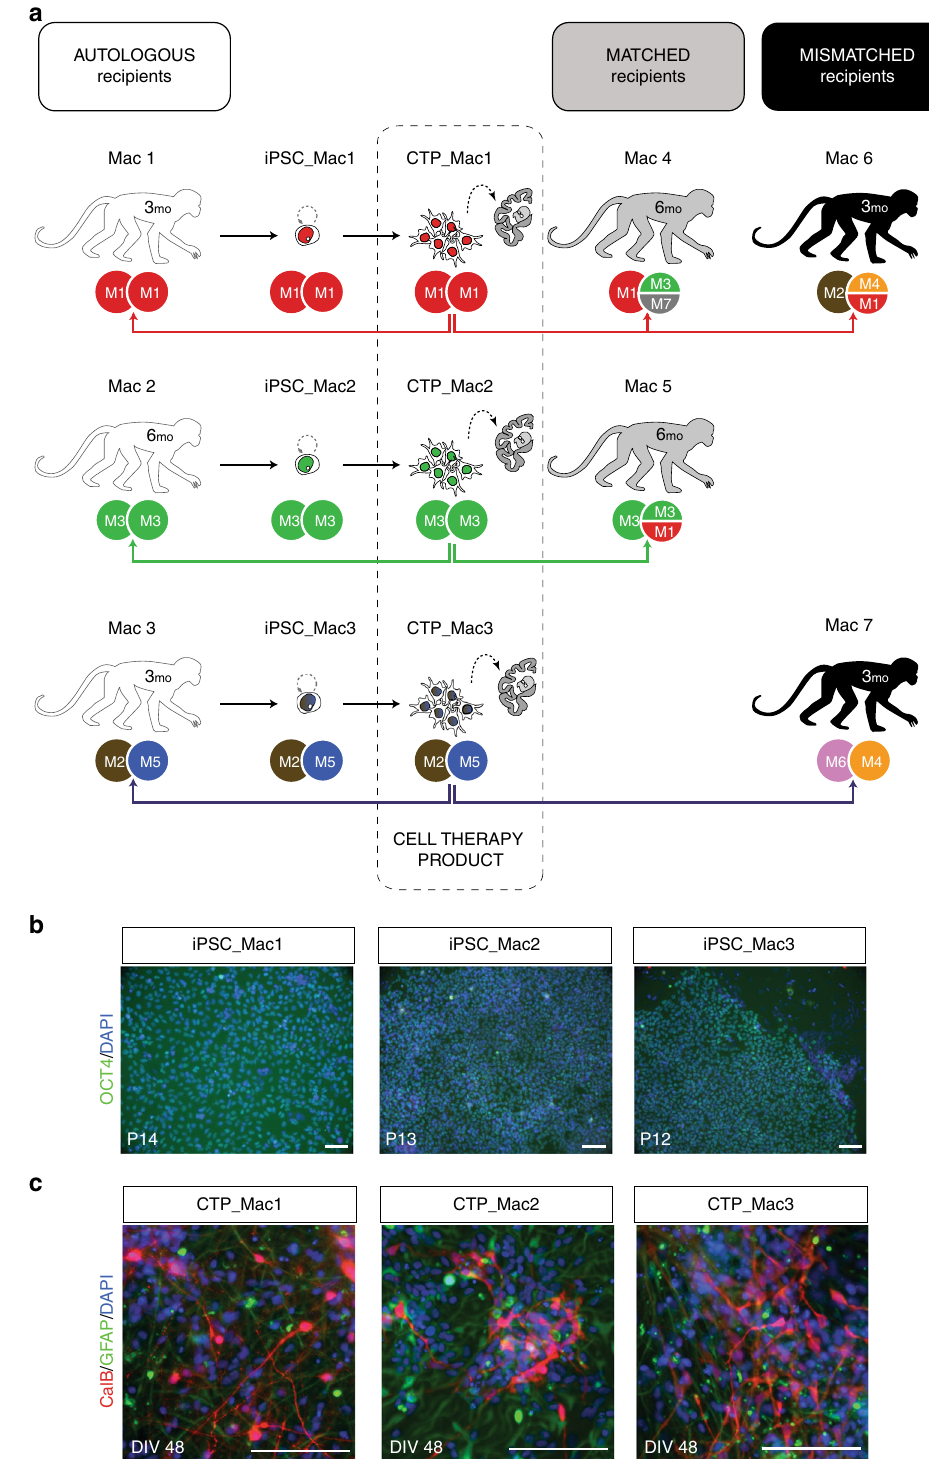
Fig. 1 Generation and in vitro characterization of cell therapy products (CTPs) with speci fi c MHC haplotypes. a Schematic representation of the experimental groups for intra-striatal cell transplantation in HD macaques (Mac) showing autologous (white, Mac 1 – 3), MHC-matched (gray, Mac 4 – 5) and MHC mismatched (black, Mac 6 – 7) recipients of CTPs derived from iPSC lines generated from PBMCs drawn from MHC homozygous (M1/M1; M3/ M3) or heterozygous (M2/M5) cell donors (white). Survival time post-transplantation is indicated on each subject as 3 or 6 months (mo). b Immunohistochemistry results showing OCT4/DAPI double staining of each of the 3 iPSCs lines derived from PBMC NHP donors (Mac 1, 2, and 3) at passage (P) 14, 13, and 12 respectively. c Staining of CTPs derived from each of the iPSC batches at in vitro differentiation day (D.I.V.) 48 showing staining for Calbindin (CalB) and astrocytes (GFAP). Scale bar: 100 µ